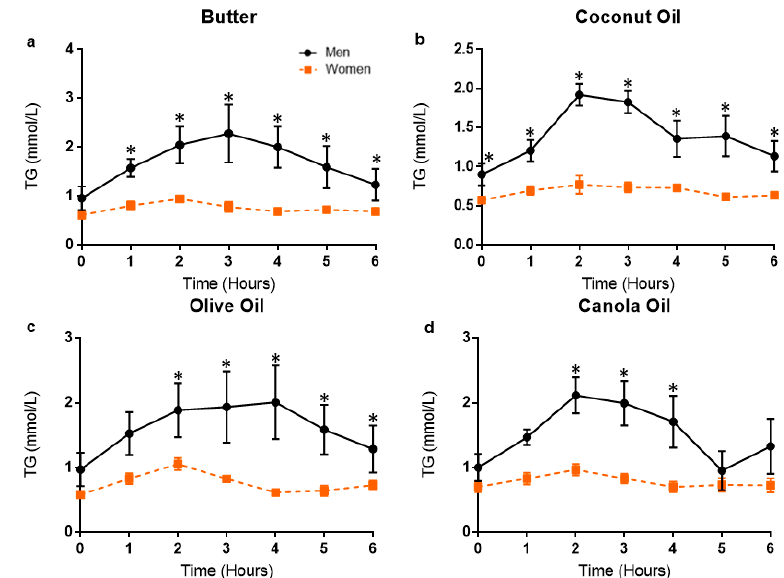
Figure 5. Postprandial responses in triglycerides in men and women based on meal trial. TG responses in men and women for each meal trial at baseline and hourly throughout the postprandial period.